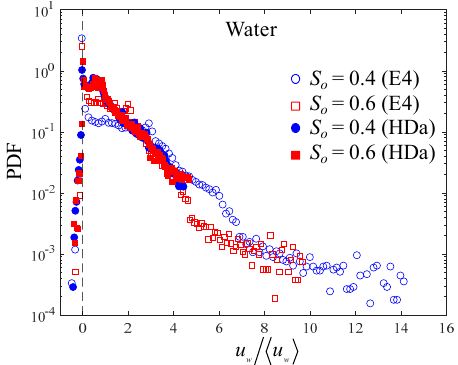
Figure A2. Sample PDFs of u w / (cid:104) u w (cid:105) , u w and (cid:104) u w (cid:105) , respectively being the horizontal component of the velocity vector of water phase and its mean. Full and empty symbols respectively are associated with sample HDa and E4. Blue circles and red squares respectively correspond to S o = 0.4, 0.6. The dashed line identifies the peak value of the sample PDFs.